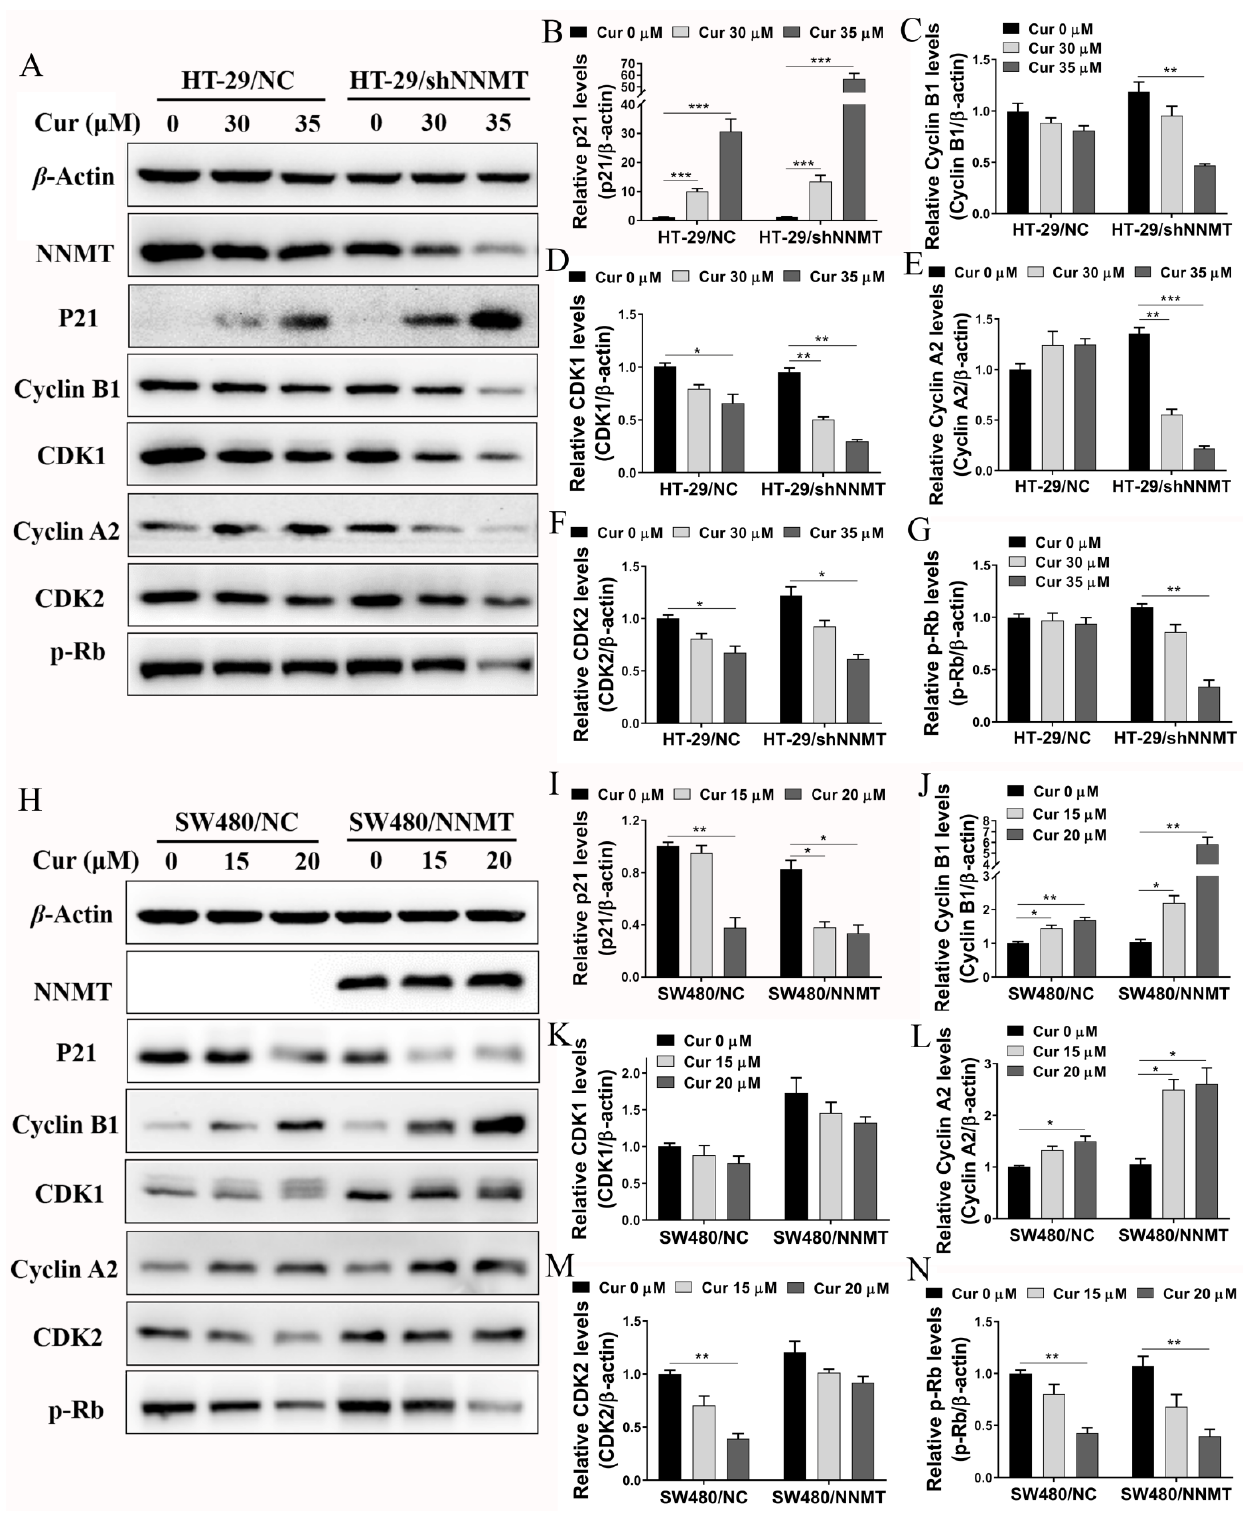
Figure 4. Cur regulates proteins related to the G2/M phase in CRC cells. Cells were treated with Cur at different concentrations for 24 h. ( A – G ) Proteins were analyzed by Western blot and were displayed as a histogram in HT-29 cell lines. The untreated group of HT-29/NC was used as the control group, which was set as 1. ( H – N ) Proteins were analyzed by Western blot and were displayed as a histogram in SW480 cell lines. The untreated group of SW480/NC was used as the control group, which was set as 1. Cur: curcumin. Data are expressed as means ± SD, n = 3, * p < 0.05, ** p < 0.01, *** p < 0.001.